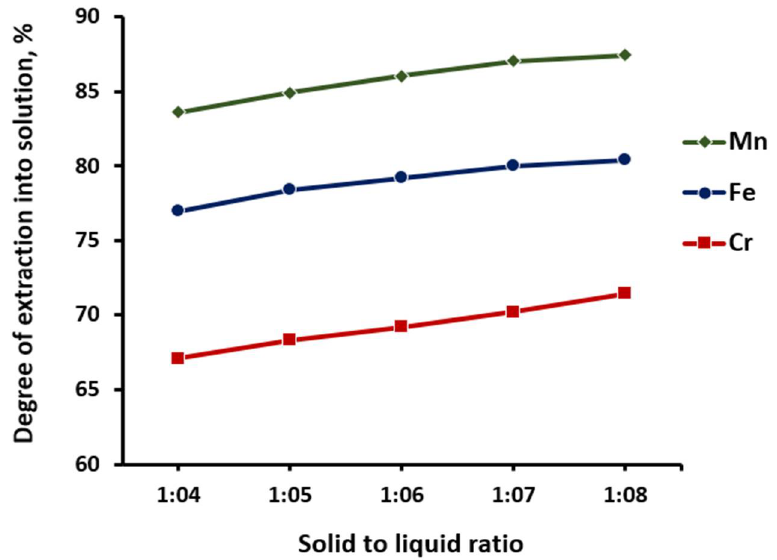
Figure 7. Dependence of the degree of extraction of manganese, iron, and chromium into the solu- tion on the solid to liquid ratio. on the solid to liquid